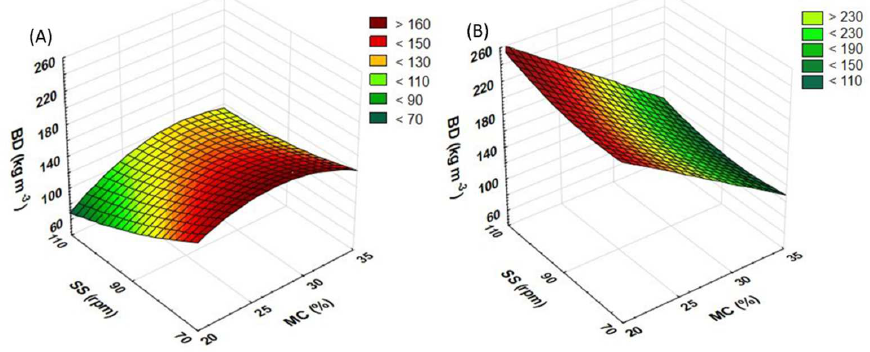
Figure 12. The result of BD measurement for extruded rapeseed straw ( A ) and buckwheat straw ( B ) before modification of the plasticizing system: MC—moisture content; SS—screw speed; BD—bulk